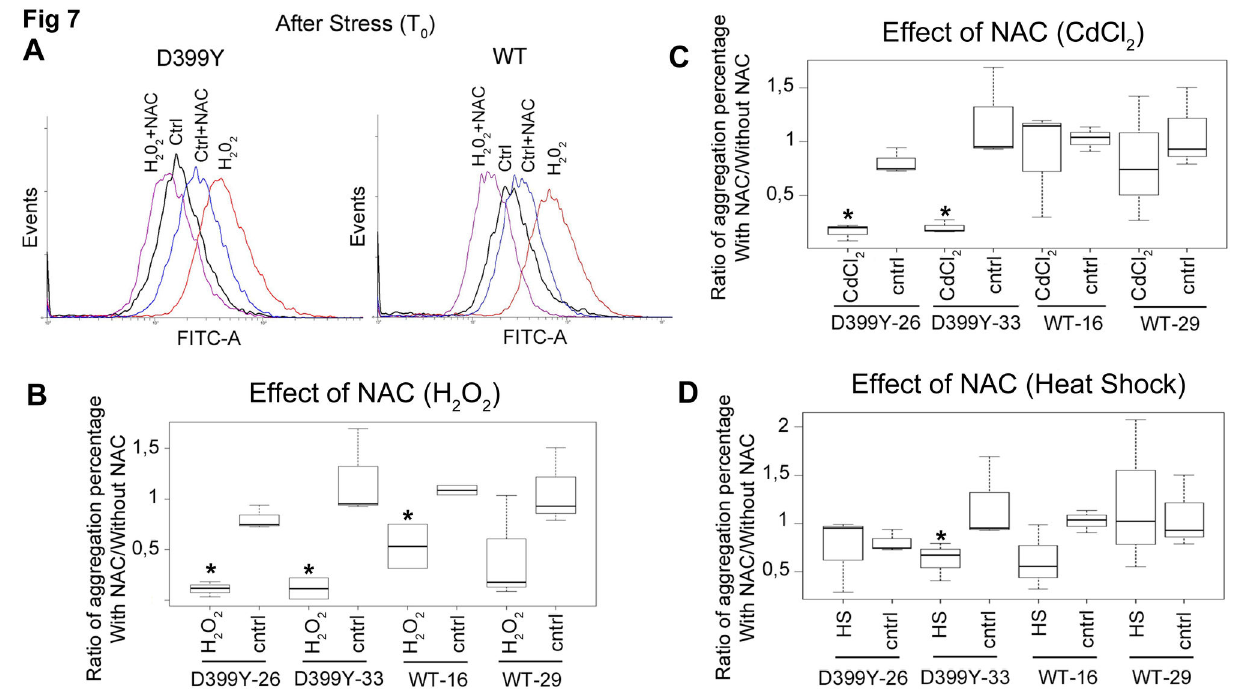
Figure 7. N-acetyl-L-cysteine effect on stress-induced aggregation model. ( A ) Oxidative Stress detection using CellROX® Green Reagent fluorogenic probe in live cells just after stress. CellROX® Green Reagent exhibits bright green photostable fluorescence upon oxidation by reactive oxygen species (ROS) measured in flow cytometer. An increase in CellROX® Green Reagent fluorescence intensity (FITC-A in log scale) is observed when cells are treated with H ( B - D ) Quantification in box plot representation of cells containing aggregates, pre-treated 16 h before stress with N-acetyl-L- cysteine (10 mM) and counted 24 h after. Cell counting was performed on three independent experiments (approx. 100 cells each). For each clone compared to its control, significant differences are indicated with asterisk (p<0.05), calculated with non-parametric test. Significant differences are indicated with asterisk (p<0.05) calculated with non-parametric test. “D399Y-Number” or “WT- Number” represents the name of the selected clone for each desmin